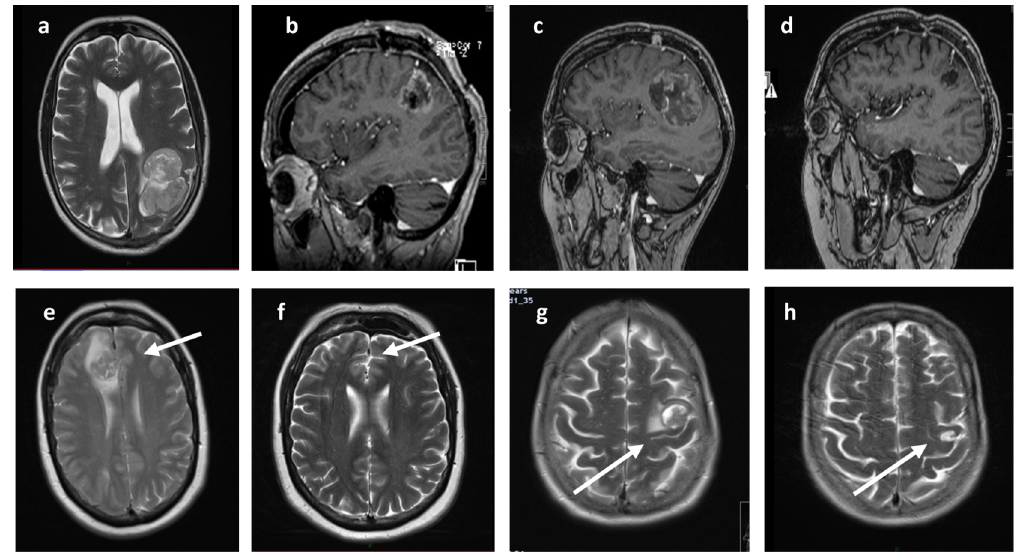
Figure 2. Radiological responses of three patients with BM on PARPi therapy (arrows denote sites of brain metastases).